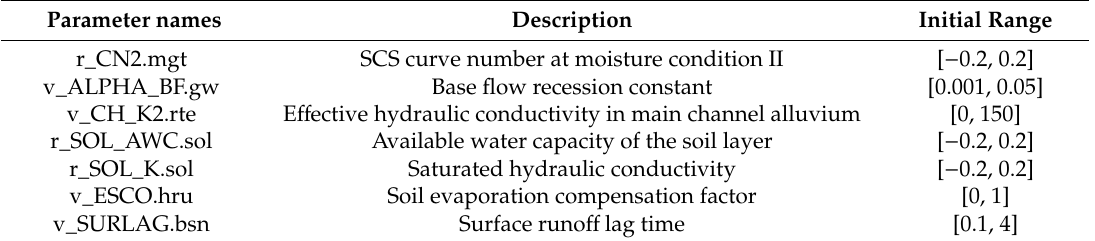
Figure 2. Availability of the data (streamflow and evapotranspiration (ET)) used in this study. Table 1. Calibrated parameters of the SWAT model for the Guijiang River Basin.